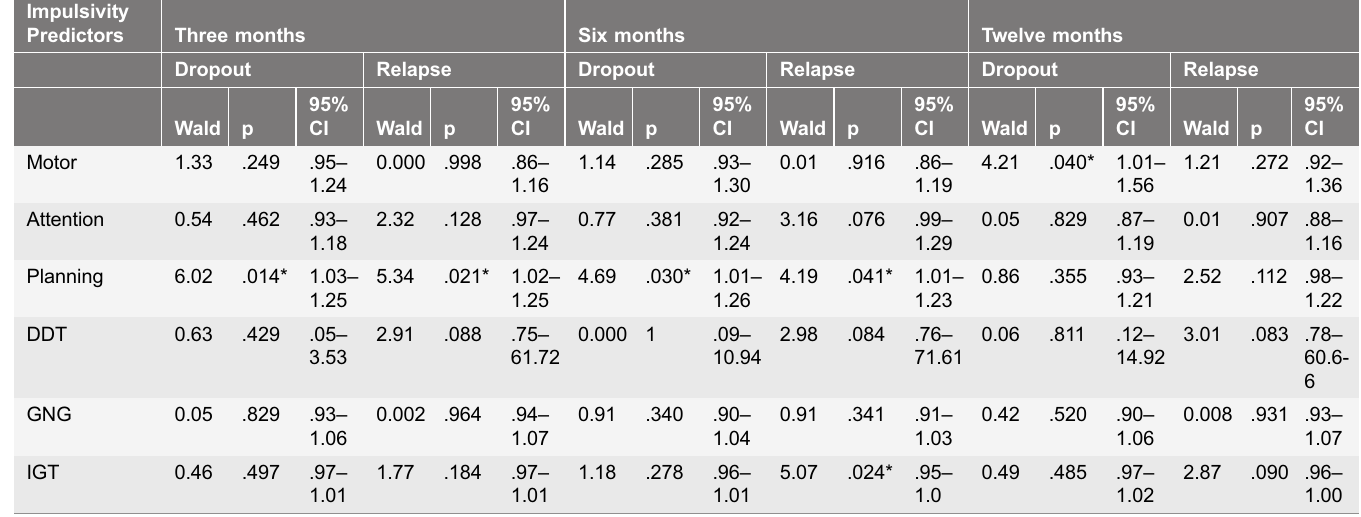
Table 4. Multinomial regression models testing the association between trait and cognitive impulsivity and smoking cessation treatment dropout and relapse at the 3-month, 6-month and 12-month endpoints. Impulsivity